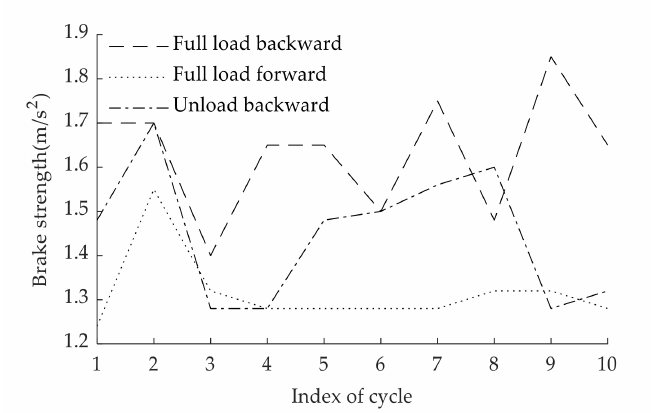
Figure 7. Max brake strength of recoverable deceleration.